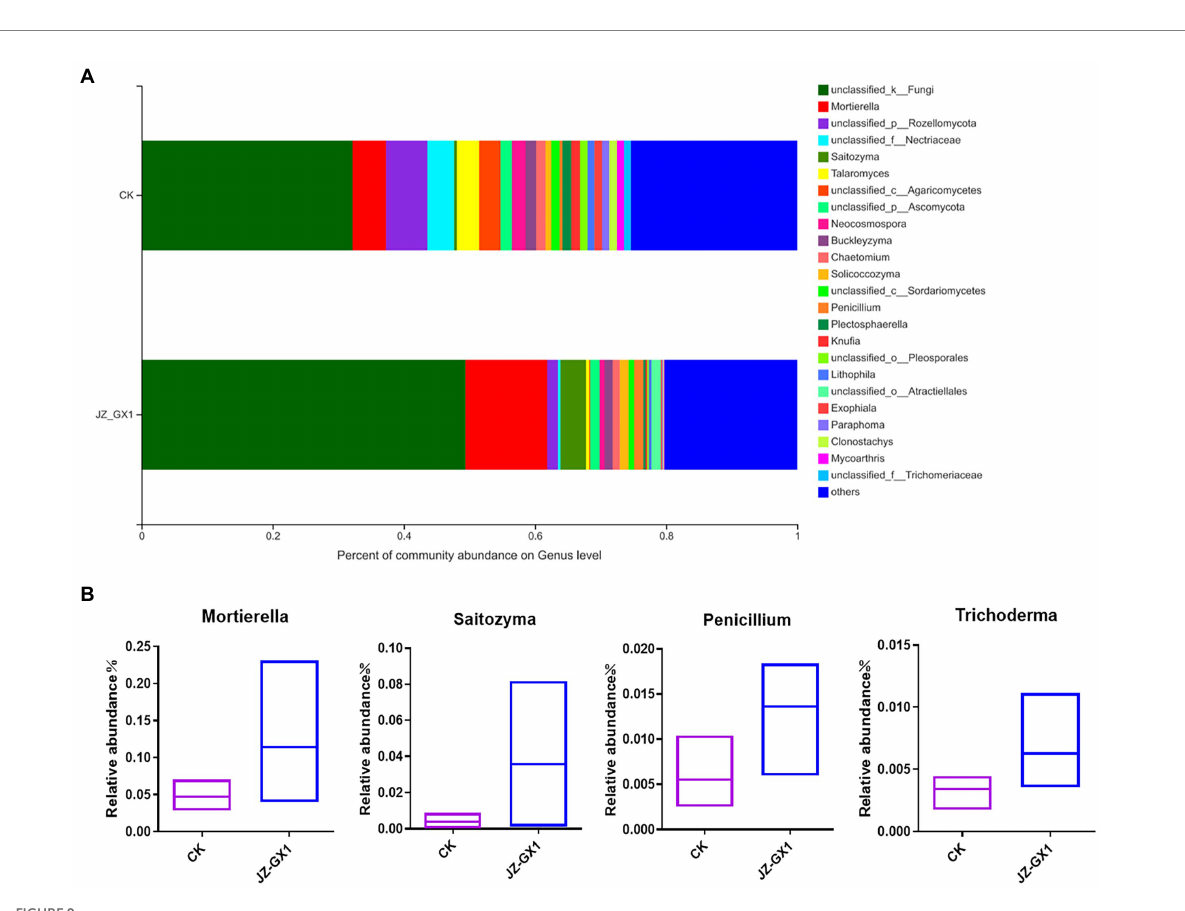
FIGURE 9 Composition of fungal communities in etiolated and green Cinnamomum camphora rhizosphere soils at the genus level. Proportion of fungi in each genus (A) and specific microorganisms (B)